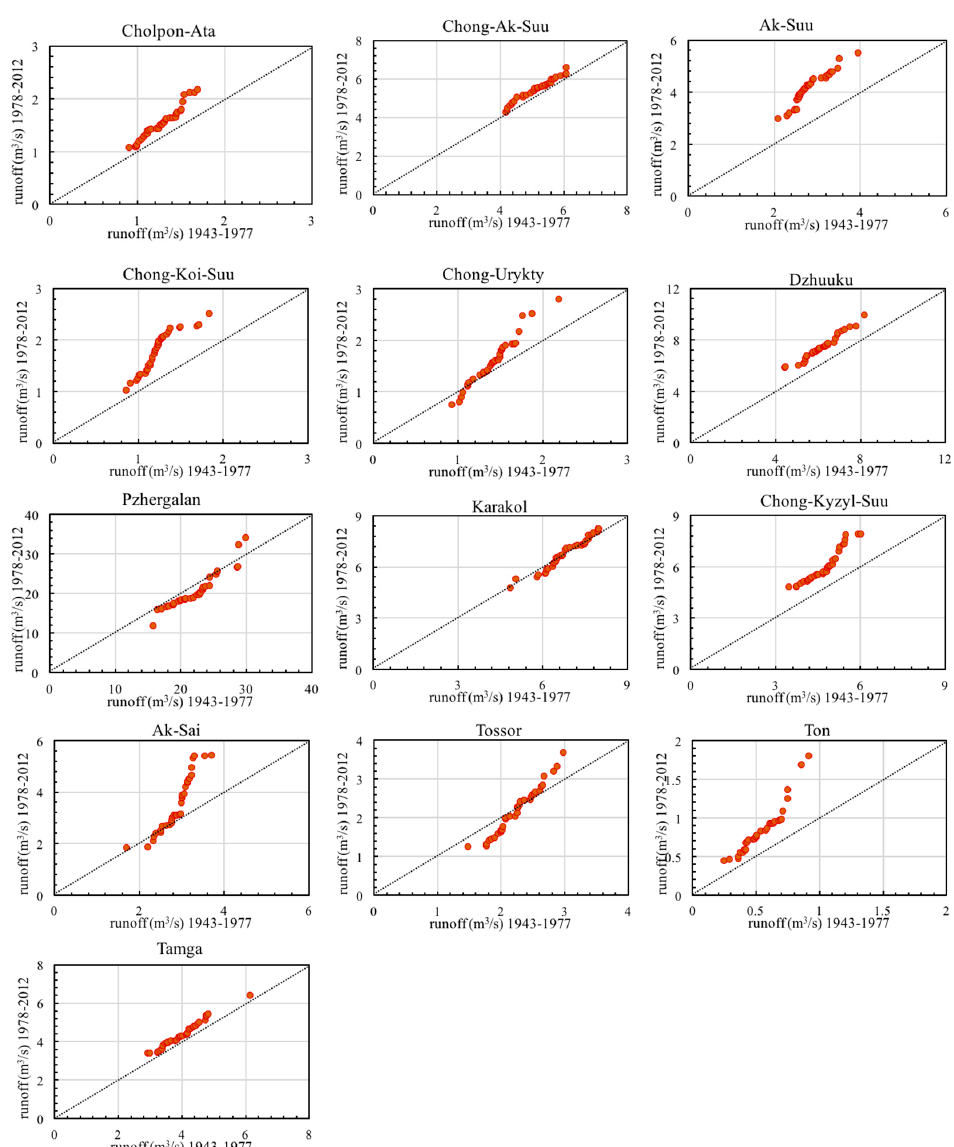
Figure 3. Analysis of the ITA for annual river runoff at 13 stations. Table 2. Analysis of MK trend test and TSM trend analysis for the temporal runoff dynamics (1943–2012) .